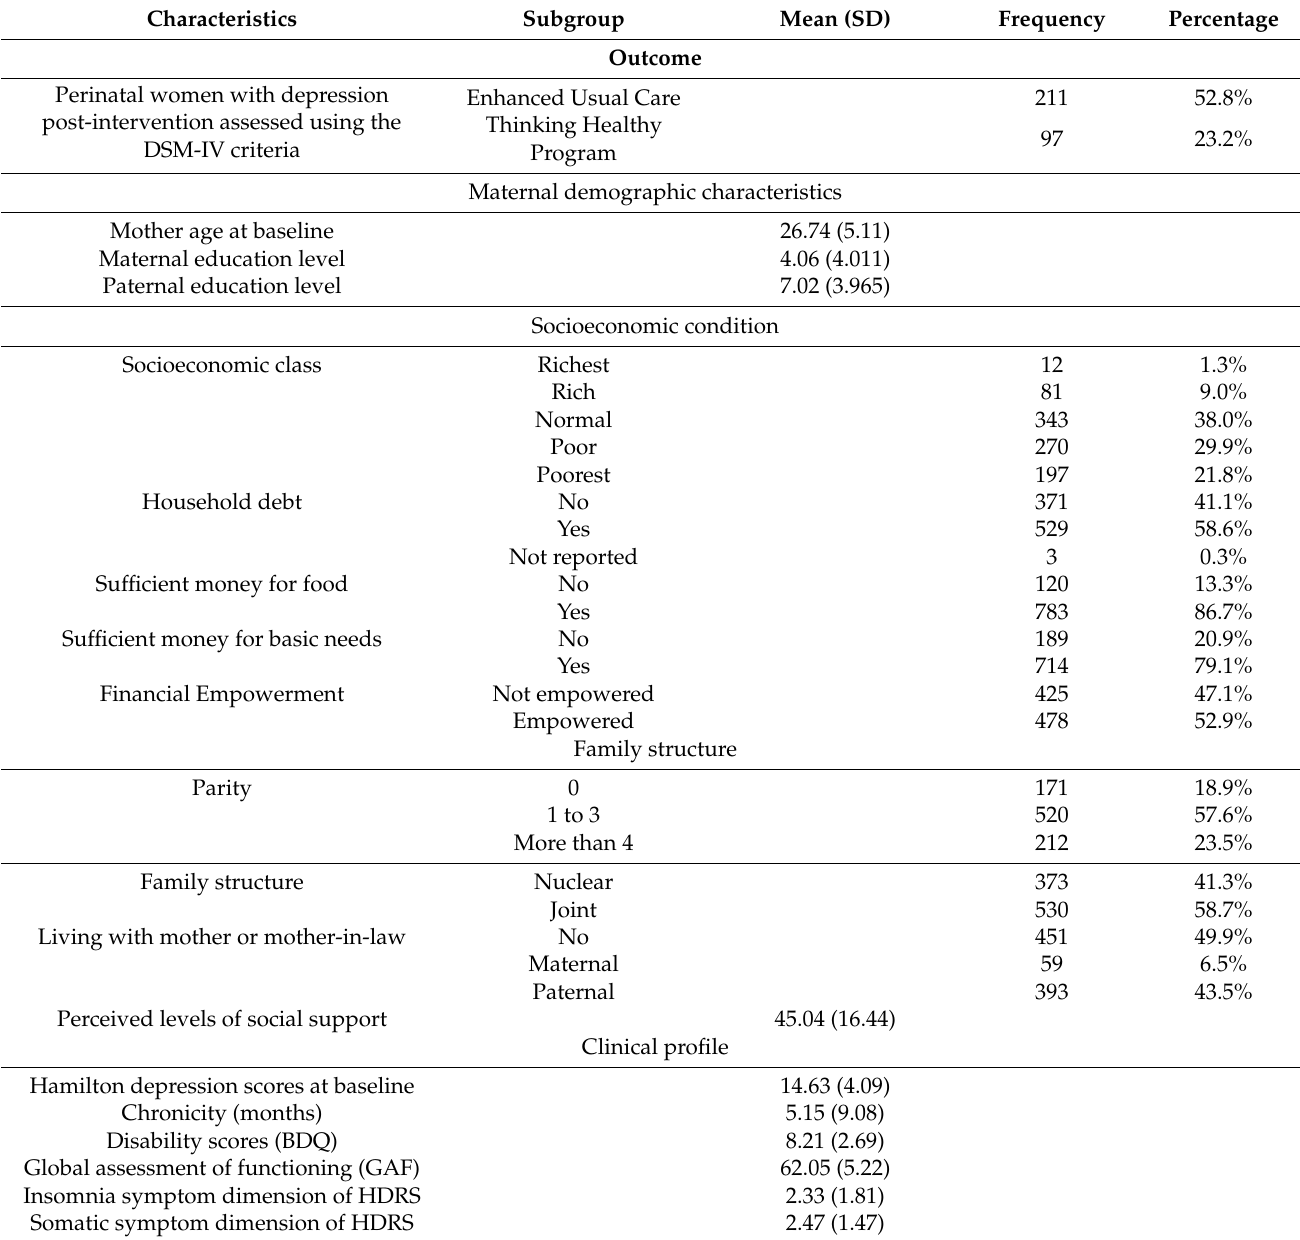
Table 1. Description of candidate predictors for inclusion in the initial prediction